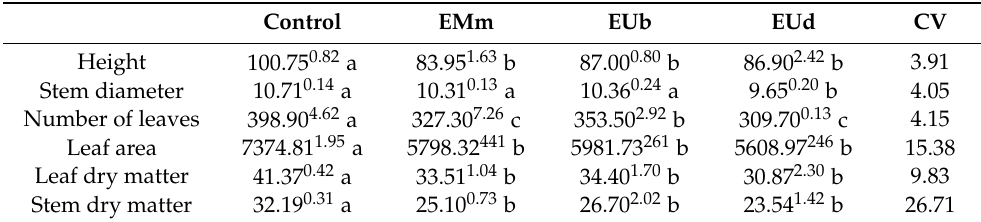
Table 2. Height, stem diameter (mm), number of leaves, leaf area (cm 2 ), leaf dry matter (g) and stem dry matter (g) of the the clonal eucalyptus hybrid I144 ( Eucalyptus urophylla × Eucalyptus grandis ) at 110 DAT.